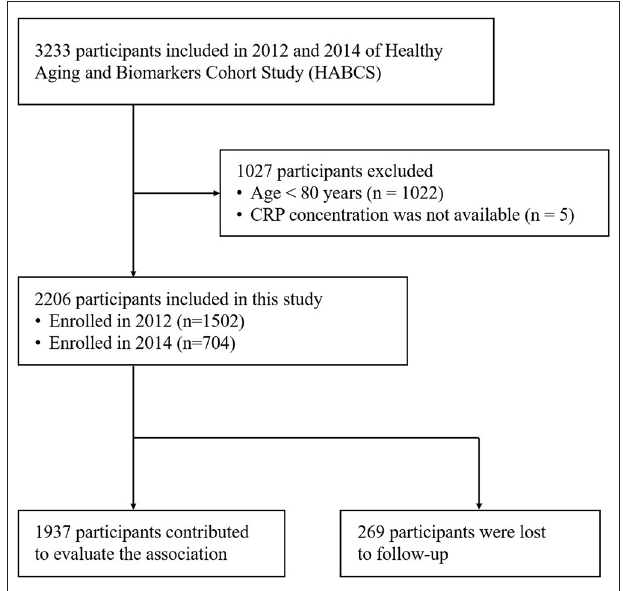
FIGURE 1 | Flowchart of participant